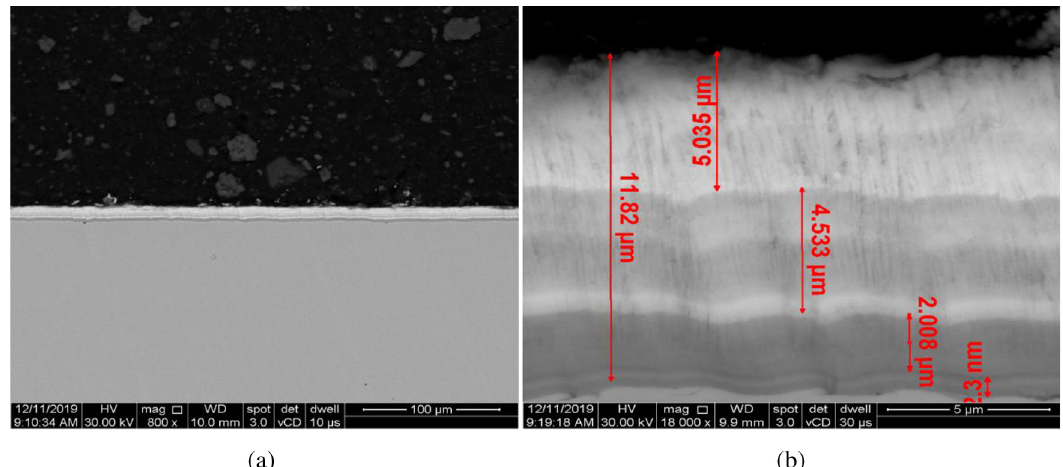
Fig. 1. SEM analysis (cid:1) morphological aspect of the fi lms deposited by EB- PVD on a Ni base super alloy substrate manufactured by 3D printing (cid:1) (a) (cid:3) 800; (b) (cid:3)